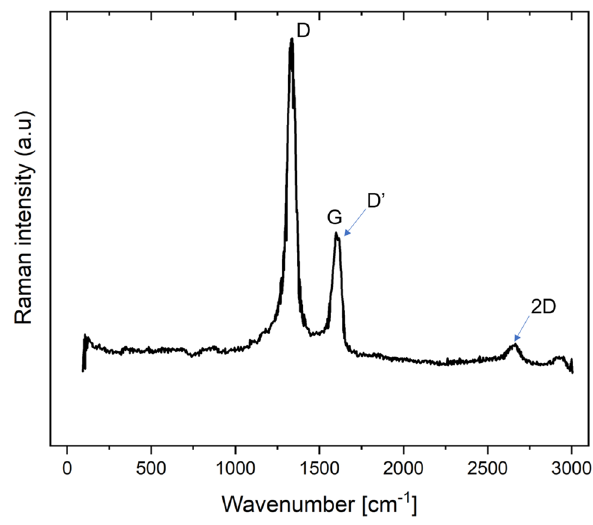
Fig. 1 Raman spectrum obtained for the carbon-coated aluminum current